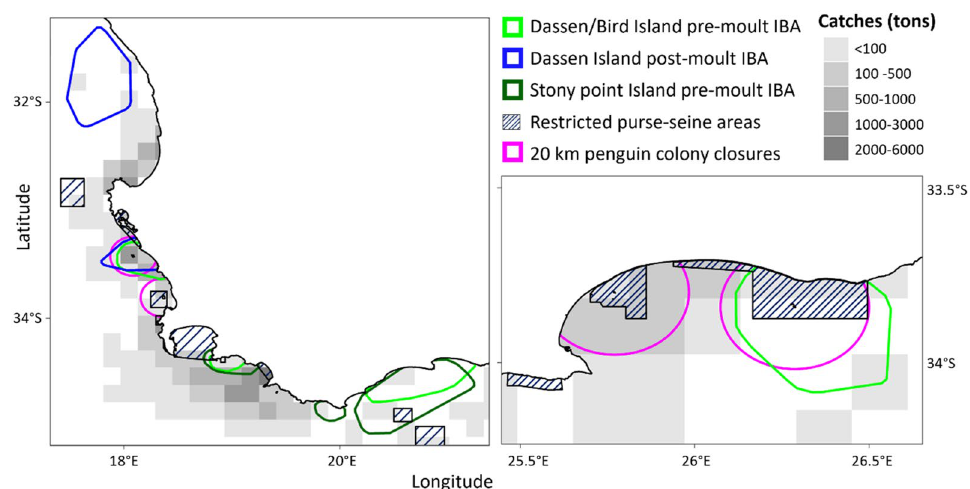
Figure 4. Proposed marine Important Bird Areas of pre- and post-moult African penguins from ( a ) Dassen Island and Stony Point and ( b ) pre-moult African penguins from Bird Island. Areas that are currently restricted to purse-seine fisheries are indicated, as well as the proposed 20 km purse-seine no-take areas around penguin colonies (Dassen, Robben, Bird and St Croix islands). Shaded areas indicate averaged accumulated catch of sardine and anchovy over 2012–2019 during September to December. Marine Important Bird Areas were only calculated for those colonies and stages that had > 10 individuals